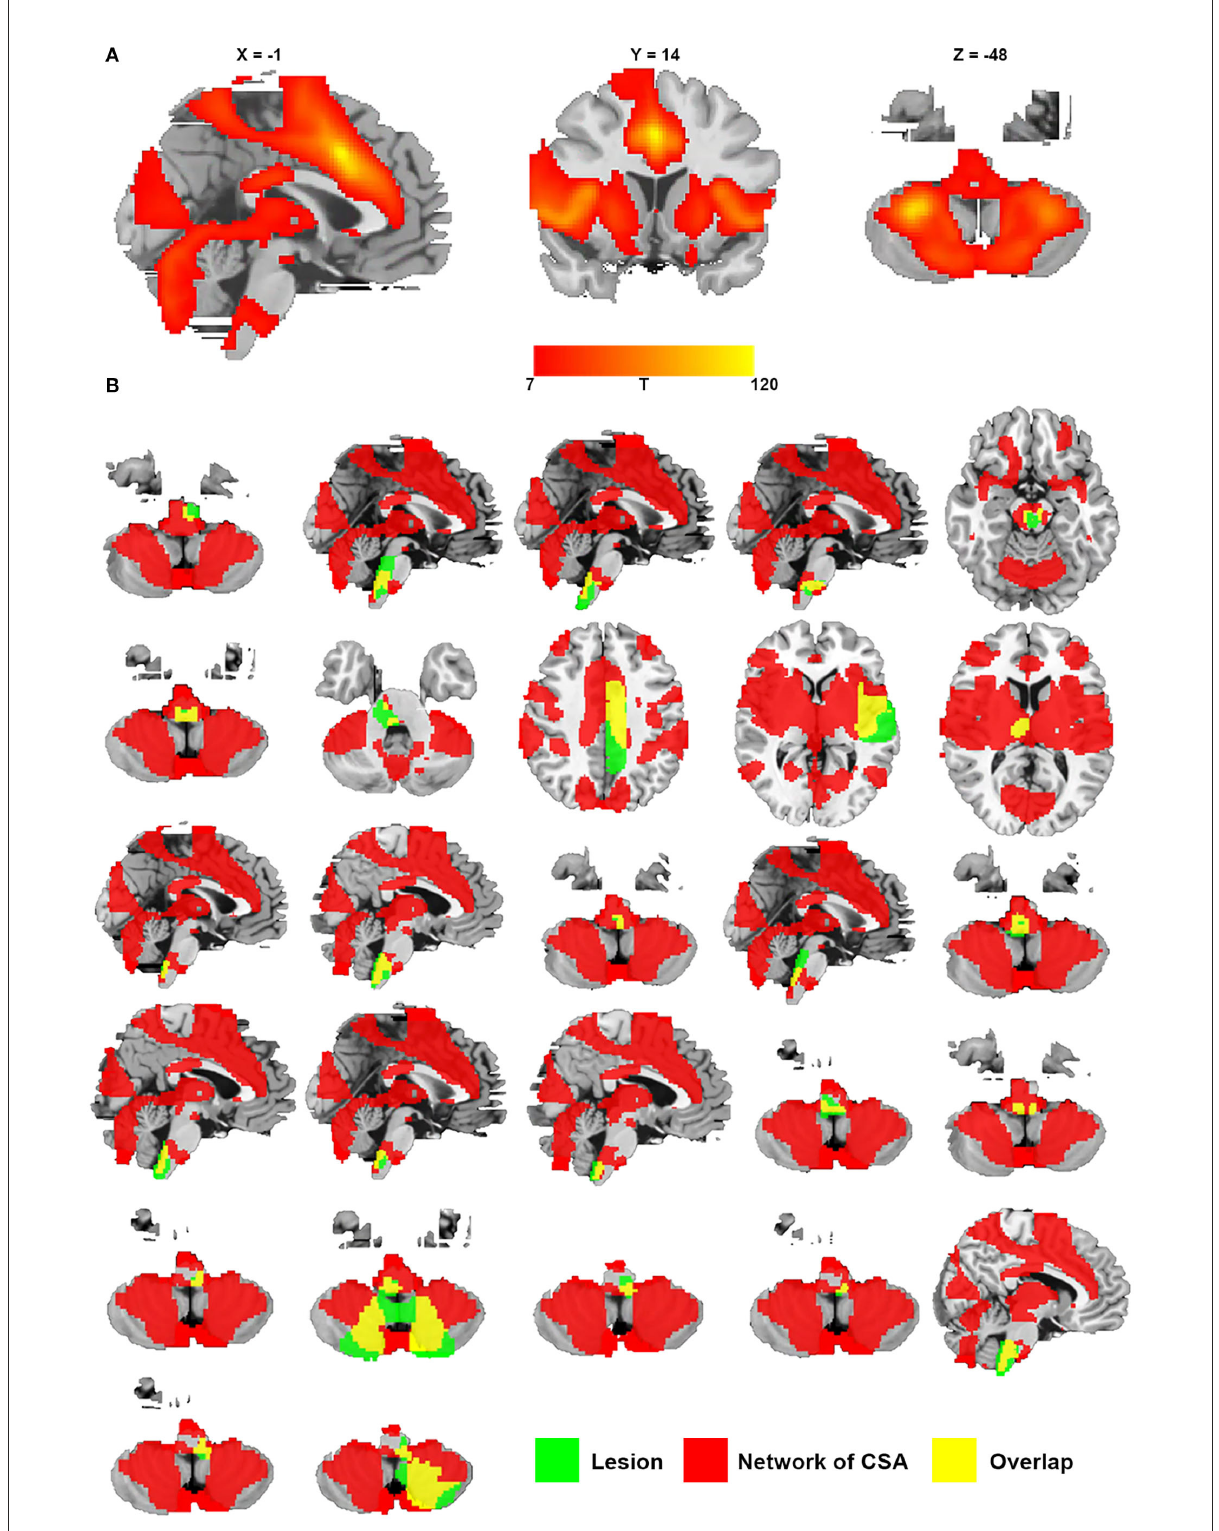
FIGURE6 Network of CSA defined by connectivity to the middle cingulate gyrus and bilateral cerebellar posterior lobes. (A) Resting-state functional connectivity with the site of the middle cingulate gyrus and bilateral cerebellar posterior lobes. (B) All lesions causing CSA were located in this network (green represents lesions causing CSA; red represents the network of CSA; and yellow represents the overlap of the lesion and the